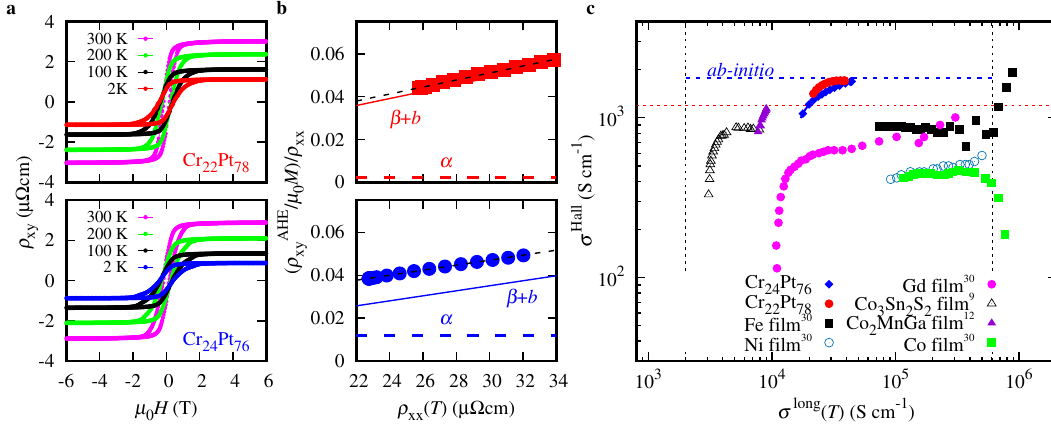
Fig. 5 Anomalous Hall effect. a Hall resistivity as a function of external magnetic fi eld and temperature. b Extraction of skew scattering ( α dashed lines) and the side-jump + intrinsic ( β þ b solid lines) from the experimental Cr 22 Pt 78 (red) and Cr 24 Pt 76 (blue). Error bars are less than size of the plotted points. c Log – log plot of longitudinal temperature-dependent conductivity ( σ xx ) versus the anomalous Hall conductivity ( σ xy ) from the experimental Cr 22 Pt 78 (red) and Cr 24 Pt 76 (blue) compared to well-known metallic Fe (black squares), Ni (open blue circles), Gd (pink circles), Co (green squares), and semi-metallic fi lms Co 3 Sn 2 S 2 (open black triangles) and Co 2 MnGa (purple triangles). The dashed blue line shows the 0 K ab-initio result for the anomalous Hall conductivity. The dashed red horizontal line shows the theoretical value of 1200 S cm − 1 for Co 3 Sn 2 S 2